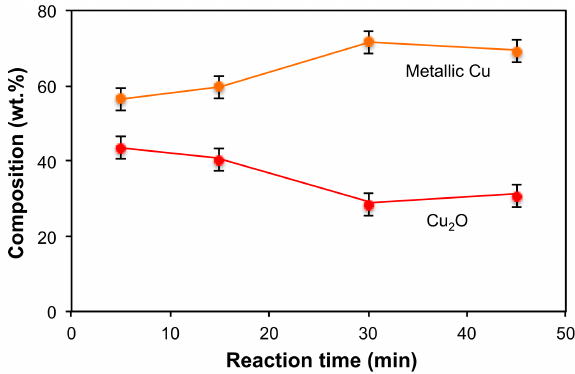
Figure 7. Plot of composition of Cu-SWCNT composites prepared by electroless deposition as determined by XRD.